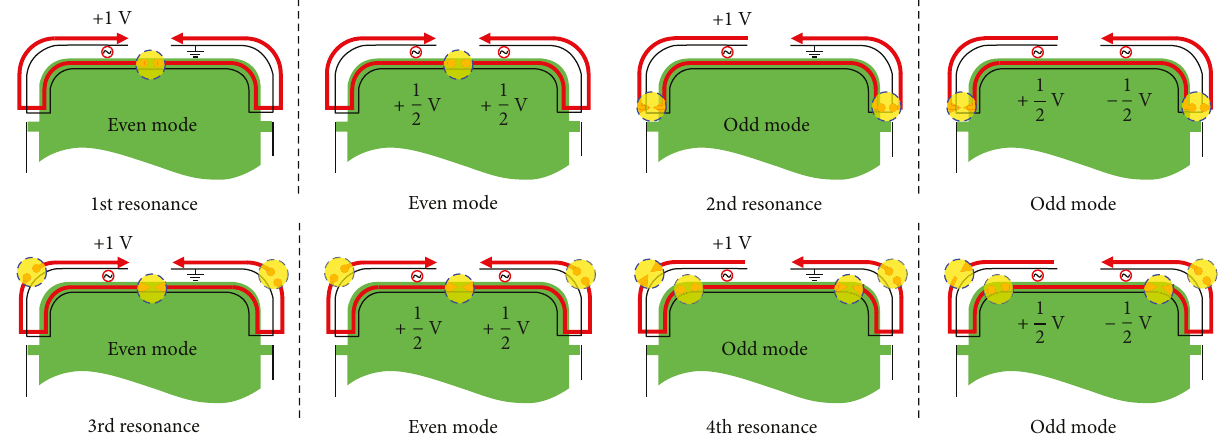
Figure 2: Simulated current distribution at each resonance modes for the crossed-loop antenna.